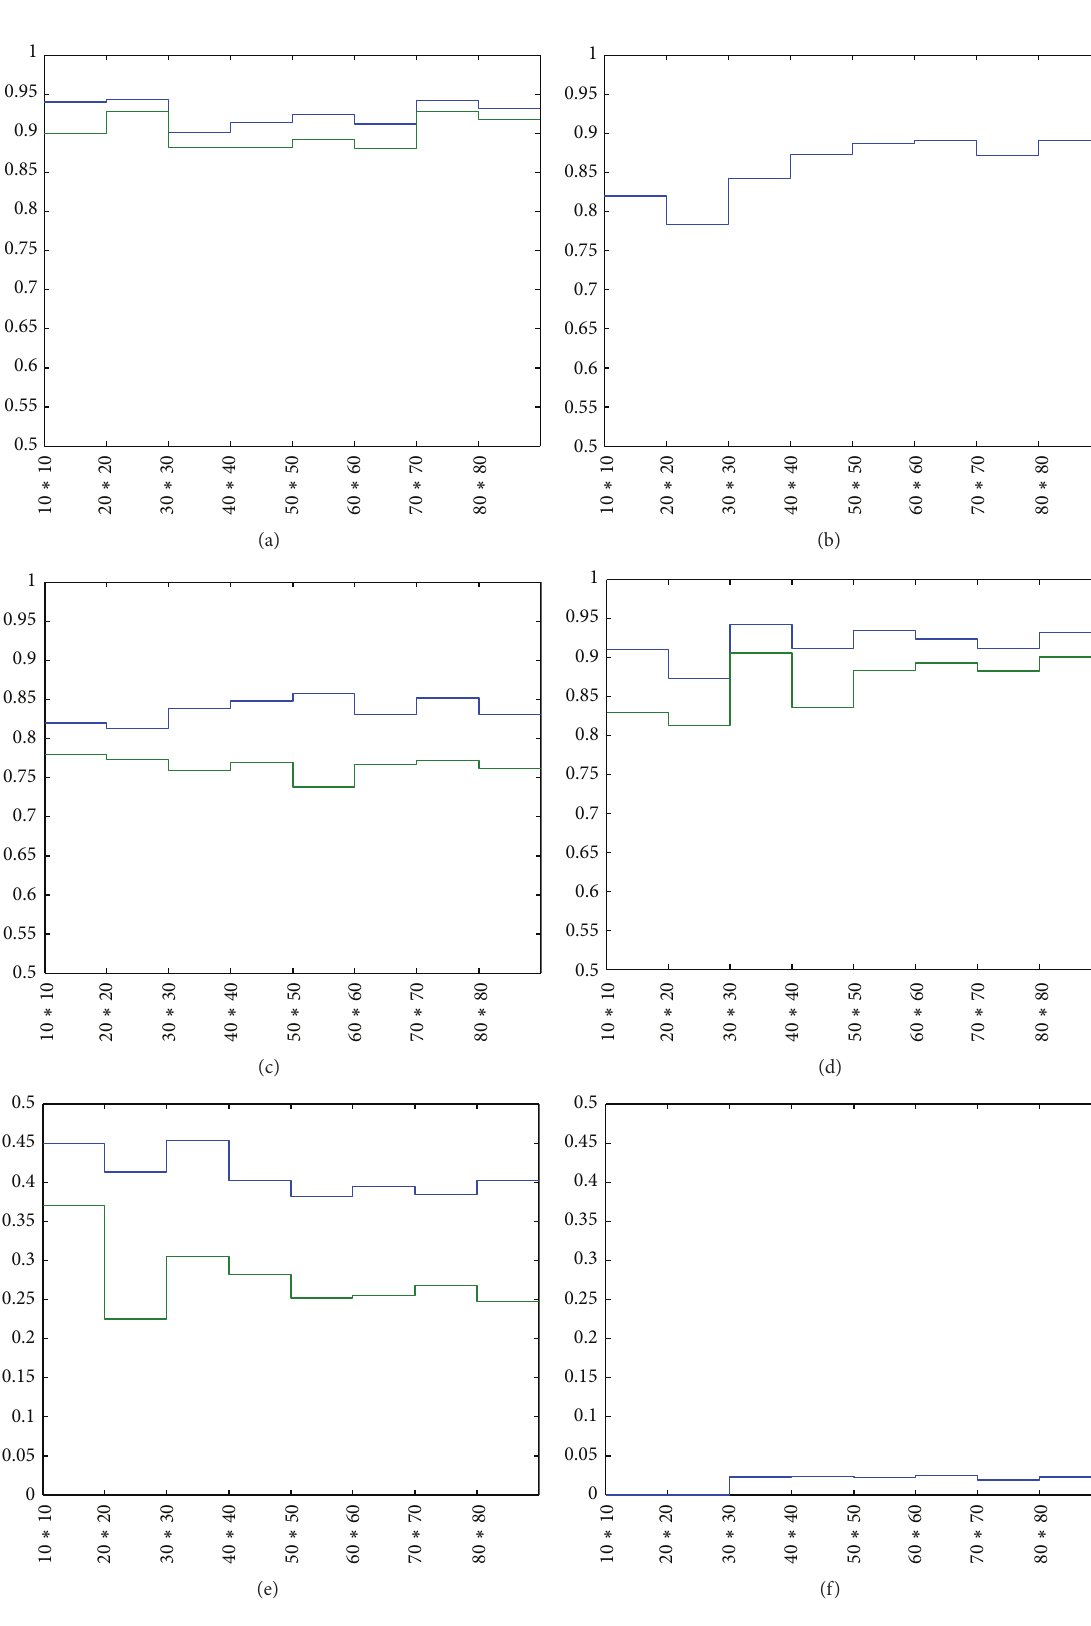
Figure 14: Simulation results on square lattices in different sizes with Moore neighborhood and 𝑓(0) = 0.50 . The 𝑥 -axis represents the lattice size, and 𝑦 -axis represents the frequency of cooperators in the final pattern. The results in (a)–(f) are, respectively, performed by the parameters region 𝑢 𝑖 0 < 𝑢 𝑖+2 1 (𝑖 = 1,2,...,6) ; 𝑢 1 0 > 𝑢 3 1 , 𝑢 𝑖 0 < 𝑢 𝑖+2 1 (𝑖 = 2,3,...,6) ; 𝑢 6 0 > 𝑢 8 1 , 𝑢 𝑖 0 < 𝑢 𝑖+2 1 (𝑖 = 1,2,...,5) ; 𝑢 𝑖 0 > 𝑢 𝑖+2 1 (𝑖 = 4,5, 6) , 𝑢 𝑖 < 𝑢 𝑖+2 (𝑖 = 1,2, 3) , 𝑢 5 < 𝑢 8 𝑢 𝑖 > 𝑢 𝑖+2 (𝑖 = 4, 5, 6) , 𝑢 𝑖 < 𝑢 𝑖+2 (𝑖 = 1, 2, 3) , 𝑢 5 > 𝑢 8 𝑢 𝑖 > 𝑢 𝑖+2 (𝑖 = 1, 2, 3) , 𝑢 𝑖 < 𝑢 𝑖+2 (𝑖 = 4,5, 6) 0 1 0 1 ; 0 1 0 1 0 1 , and 0 1 0 1